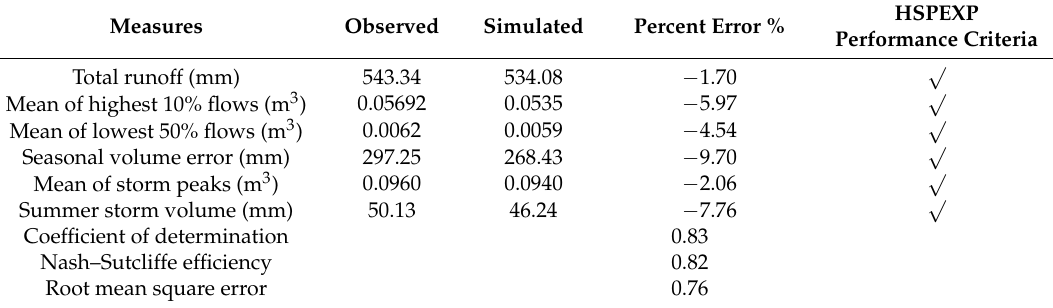
Table 5. Summary of calibration and validation statistics for the event condition.